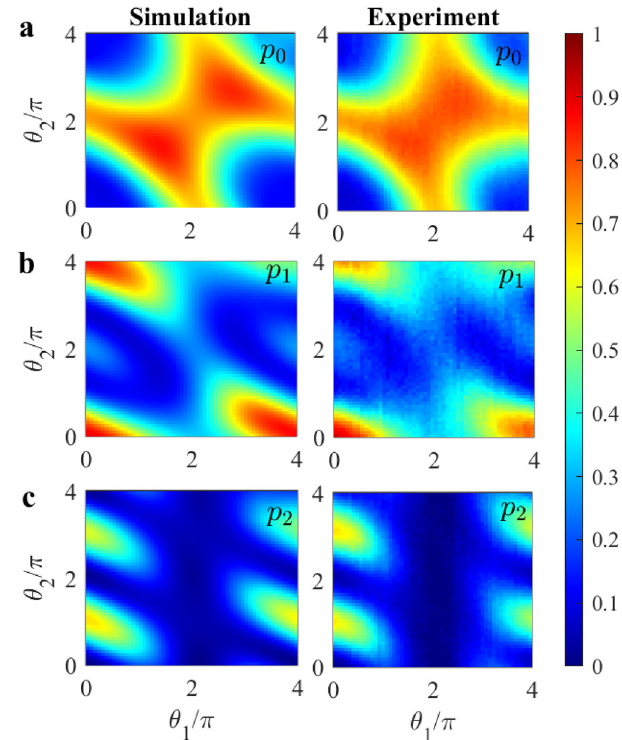
Fig.4|Probabilitiesforthe N =2case. 2Dprobabilitymapsforthe a groundstate ( p 0 ), b fi rstexcitedstate( p 1 ),and c secondexcitedstate( p 2 )asafunctionof B -pulse strengths θ 1 and θ 2